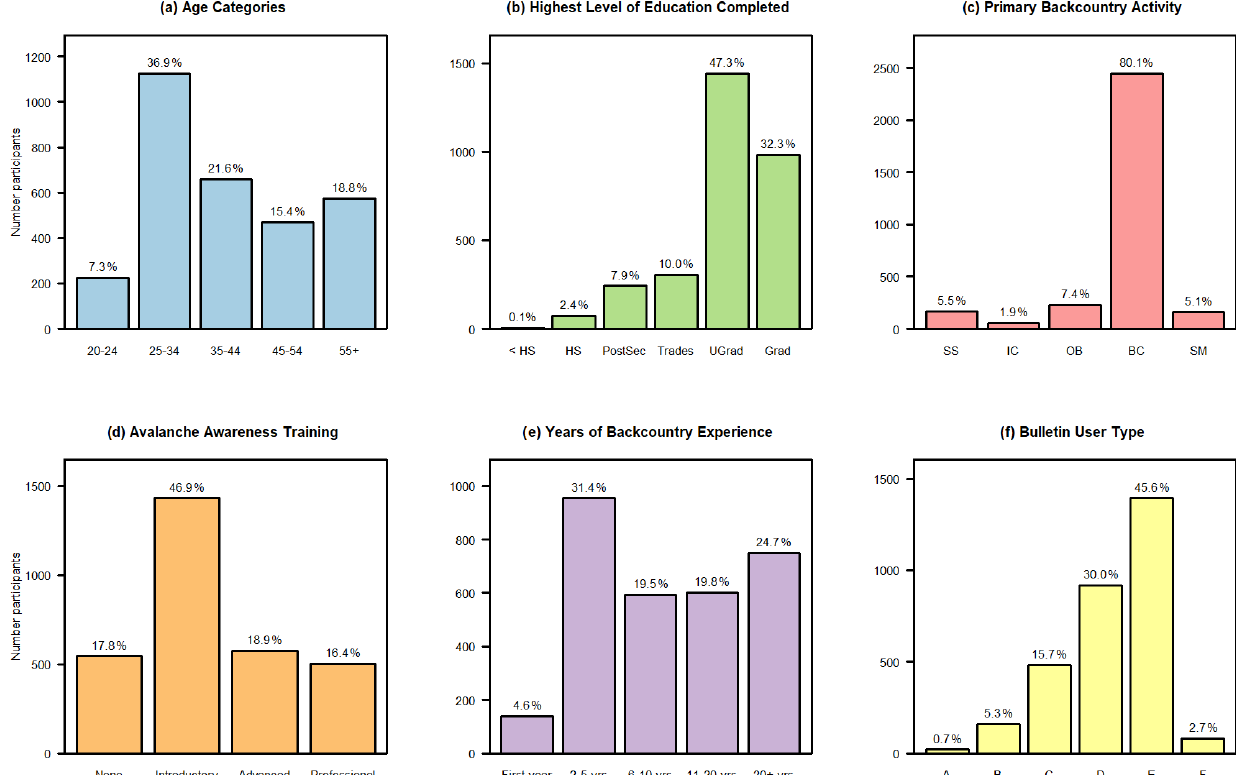
Figure 4. Summary of demographic characteristics of participants, including (a) age categories, (b) the highest level of education completed ( < HS – less than high school; HS – high school completed; PostSec – some post-secondary education (not completed); Trades – trades of non-university certificate or diploma; UGrad – completed university; Grad – graduate degree), (c) primary backcountry activity (SS – snow shoeing; IC – ice climbing; OB – out-of-bounds skiing; BC – backcountry skiing; SM – mountain snowmobiling), (d) avalanche awareness training, (e) years of backcountry experience, and (f) bulletin user